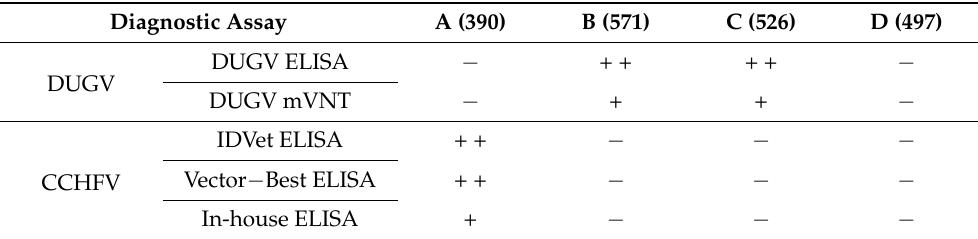
Figure 6. CCHFV IFA (Euroimmun, Lübeck): Cells expressing CCHFV GPC ( I ) and non-transfected control cells ( II ) are depicted. Serum A (CCHFV+/DUGV − ) led to an undistinguishable fluorescent signal compared to sera B and C (CCHFV − /DUGV+). Serum D (CCHFV − /DUGV − ) served as the negative control. Table 7. Corresponding serological data to Figure 6.